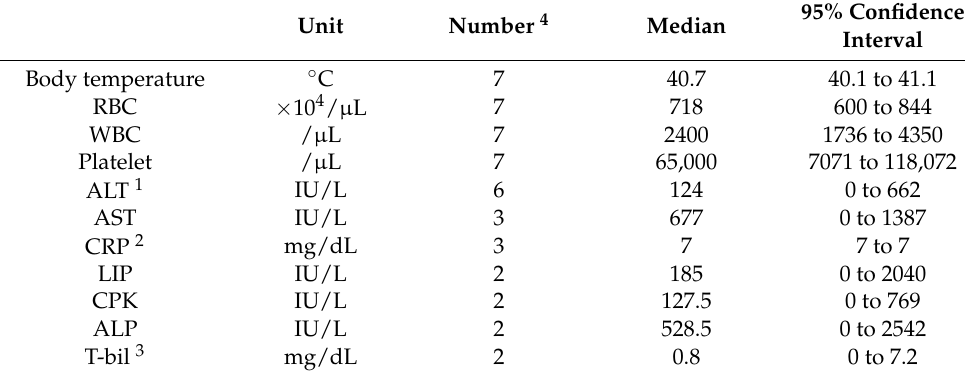
Table 2. Laboratory findings of the dogs with SFTS at the first